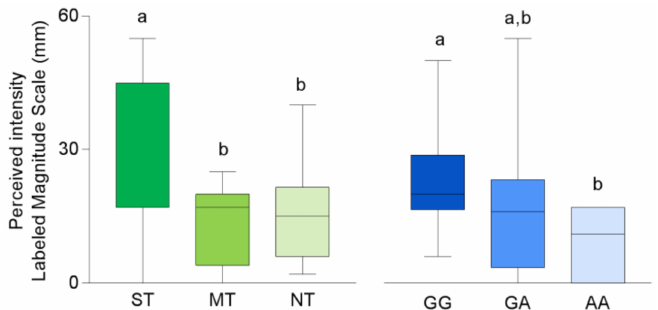
Figure 2. Box-and-whisker plots showing the minimum, first quartile, median, third quartile, and maximum of each set of perceived intensity data evoked by taste stimulation with oleic acid (30 µ L) in super-tasters (ST; n = 10), medium-tasters (MT; n =13) and non-tasters (NT; n = 12) and in volunteers with genotypes GG ( n = 9), GA ( n = 20) and AA ( n = 6) of CD36 . Different letters indicate a significant difference ( p ≤ 0.046; Duncan’s test and p = 0.047 Fisher LDS test, subsequent one-way ANOVA). Fungiform papillae density varied with PROP taster status ( F 2,32 = 18.712; p < 0.001) (Figure 3). Super-tasters showed a higher density than medium-tasters ( p < 0.001; Duncan’s test), whose values were higher than those of non-tasters ( p = 0.032; Duncan’s test). No differences in fungiform papillae density related to the CD36 polymorphism were found ( p <